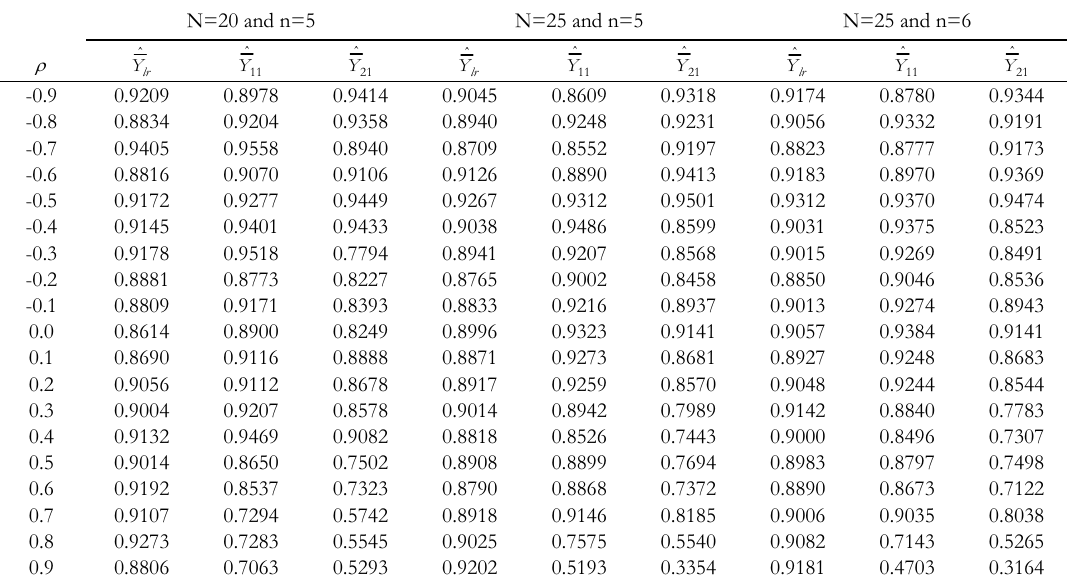
The 95% coverage by three estimators for different values of N, n and different values of correlation coefficients N=20 and n=5